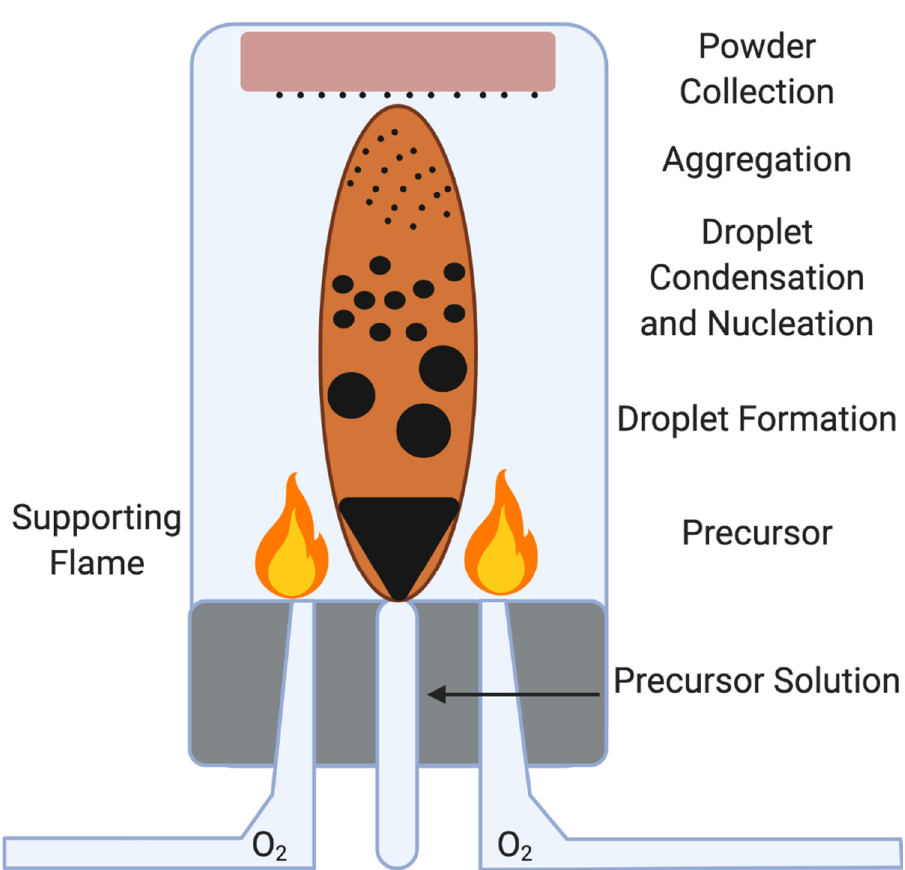
Figure 4. Nanoparticle formation by Flame Spray Pyrolysis. Flame spray pyrolysis is a complicated process that involves the breakdown of a precursor (typically an organic solvent) into its monomers, which are then reacted with hydrocarbons and catalyzed by very high temperatures. The resulting nanomaterials are collected on substrate. FSP is scalable to industrial levels, but is highly dangerous and the carbon dioxide biproducts are major contributors to the greenhouse